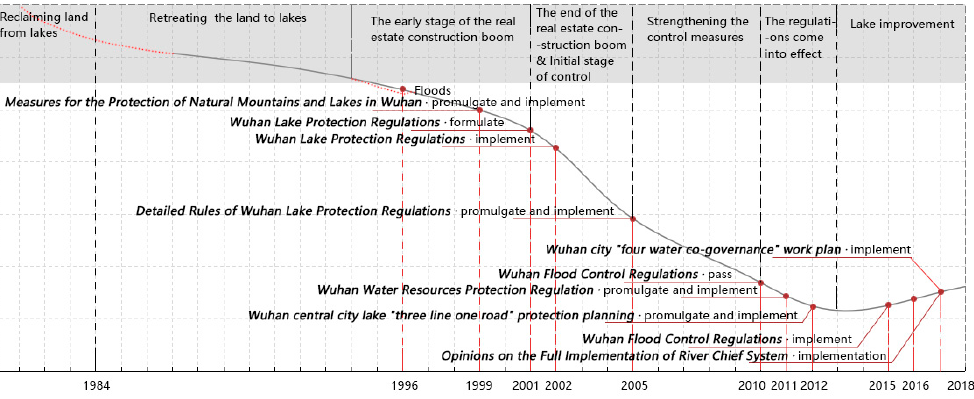
Figure 9. Changes in lake policy from 1987–2018.